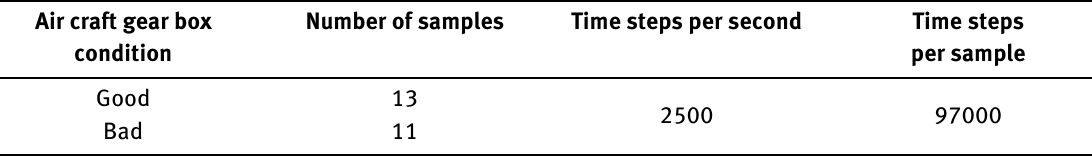
Table 1: Aircraft gearbox vibration